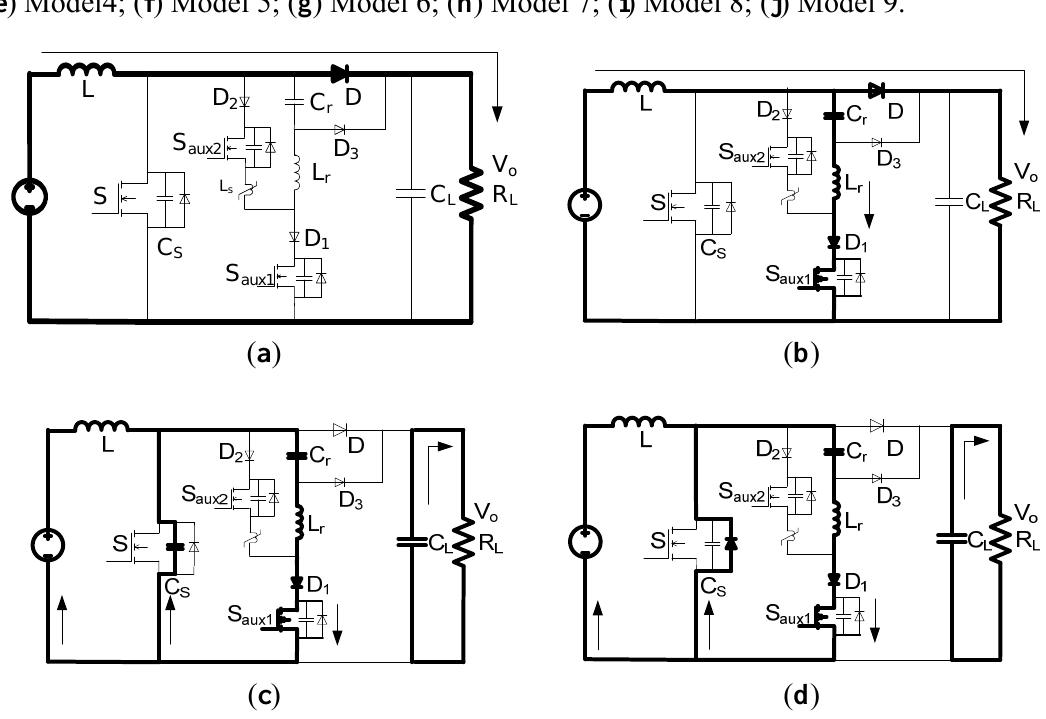
Figure 6. Modes of operation. ( a ) Model 0; ( b ) Model 1; ( c ) Model 2; ( d ) Model